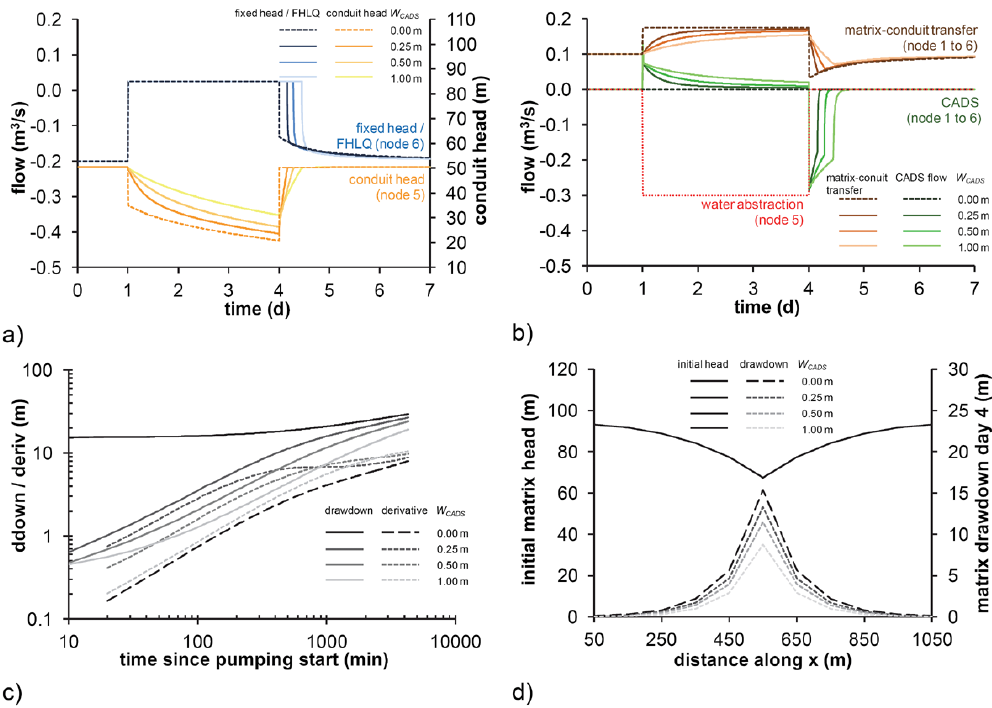
Fig. 7. Simulation results for the enhanced model (with CADS and FHLQ boundary condition): (a) flow terms for the fixed-head/FHLQ boundary and conduit heads at node 5; (b) flow terms for matrix transfer and CADS flow; (c) log-log diagnostic plot for conduit drawdown (solid lines) and drawdown derivative (dashed lines) at node 5; (d) initial matrix head and matrix drawdown at day 4 along the cross section A–A’ (Fig.